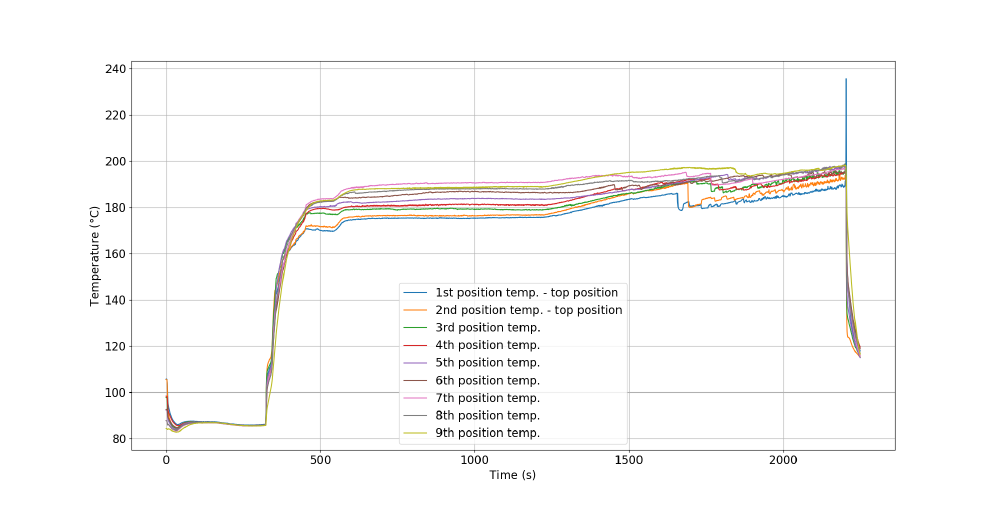
Figure 17. Temperatures during 300 kPa and 400 kg/(m 2 . s)